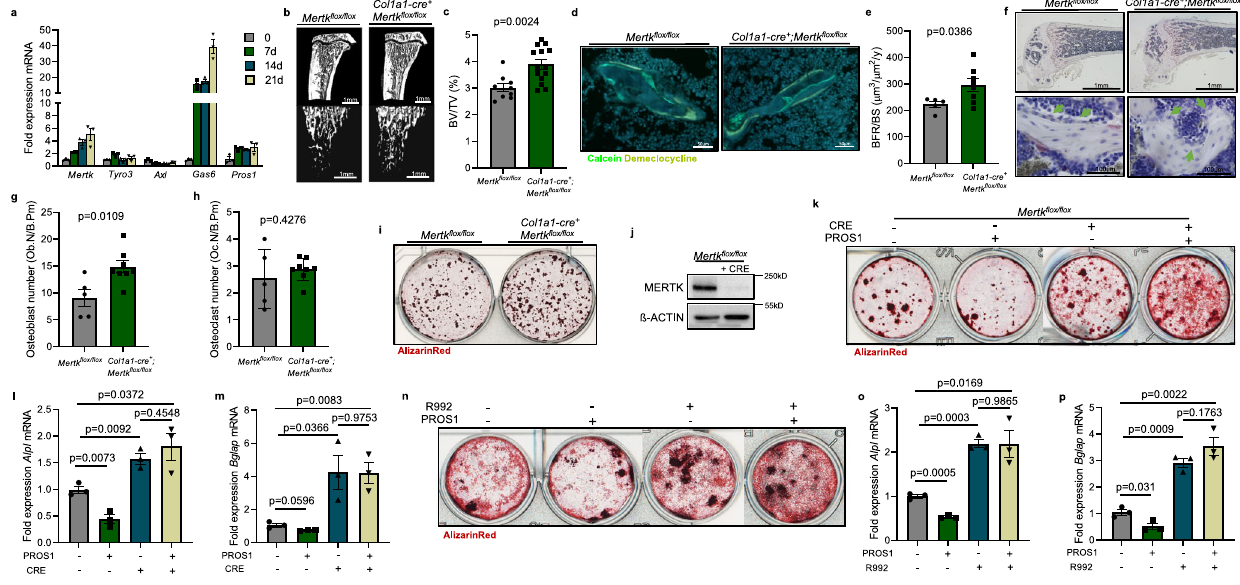
Fig.1|NegativeregulationofboneformationbyTAMreceptorMERTK.a mRNA expression analysis of TAM receptor family Mertk , Tyro3 , Axl , Gas6 , and Pros1